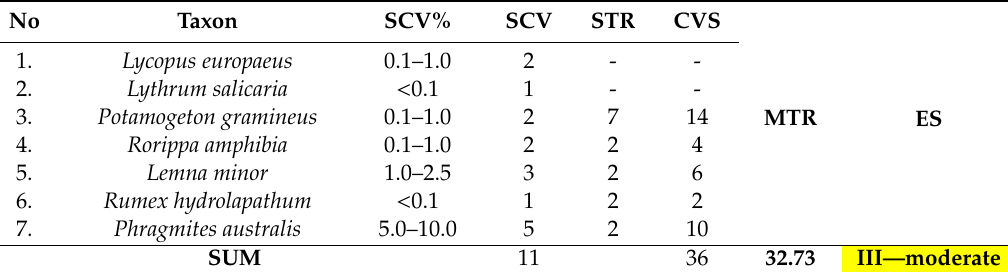
Table 11. Summary of MTR results, May 2017, section below the barrage on the ´Sl˛eza.